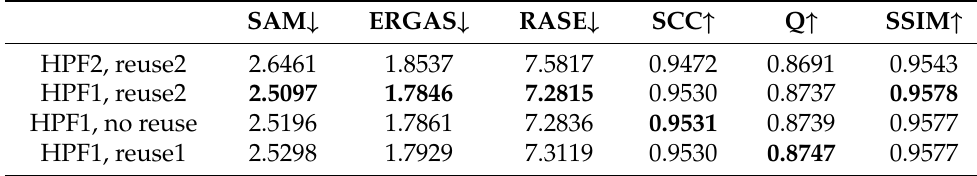
Table 3. Ablation study of different network structures on the Ikonos